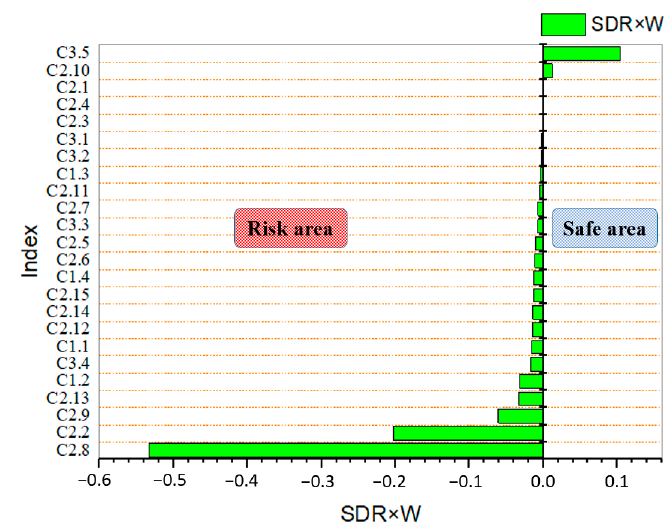
Figure 5. Partition map of the risk of the index.